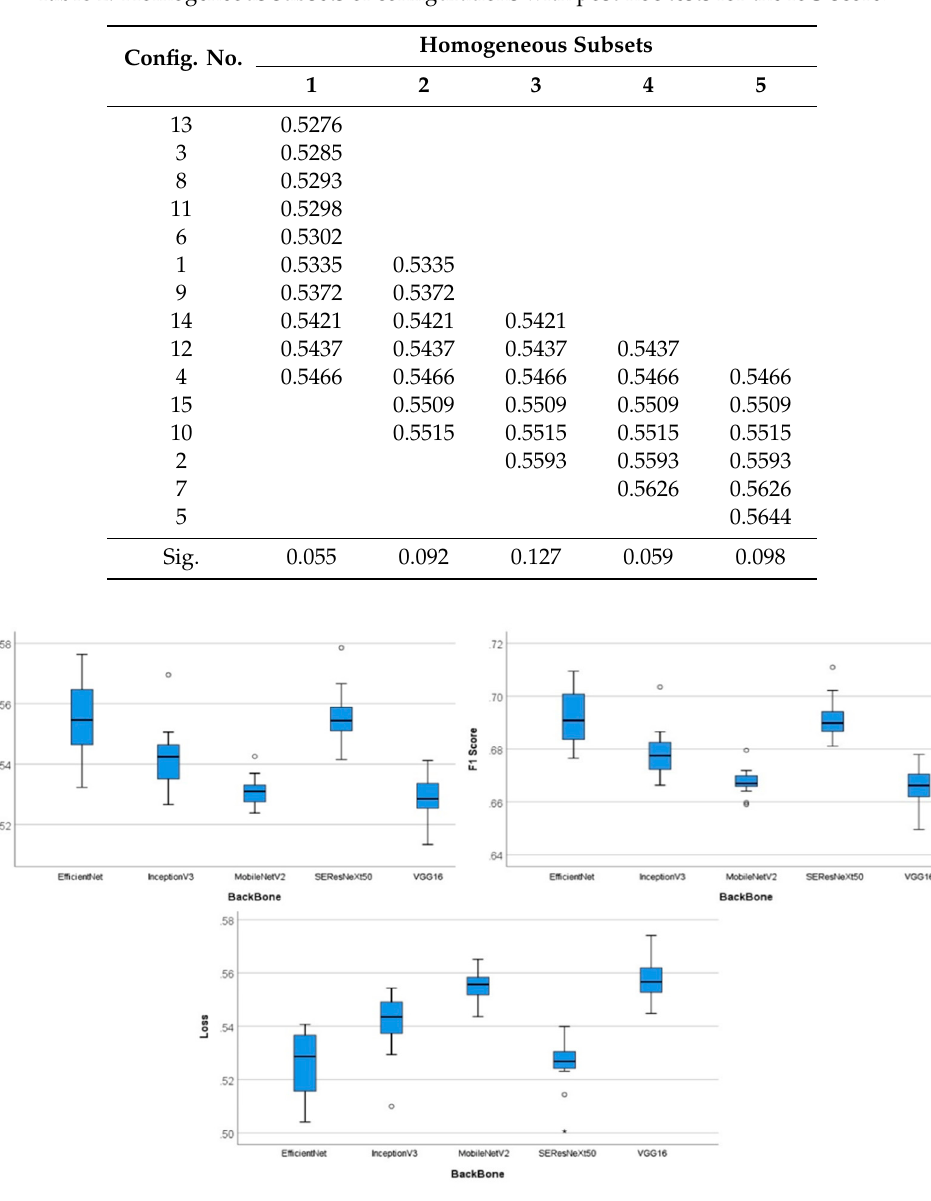
Figure 4. Boxplots of performance metrics for different backbones.